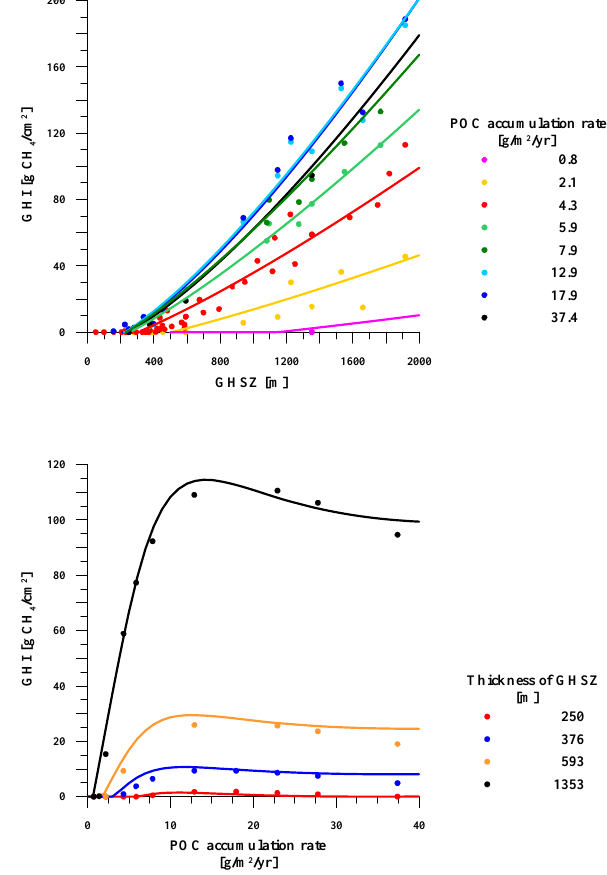
Fig. 11. Parameter analysis of the two key control parameters POCar and GHSZ: (a) relation of GHSZ and GH accumulation for Figure 11. Parameter analysis of the two key control parameters POCar and GHSZ: a) relation varying POCar; (b) relation of POCar and GH accumulation for varying of GHSZ and GH accumulation for varying POCar; b) relation of POCar and GH accumulation for varying GHSZ.